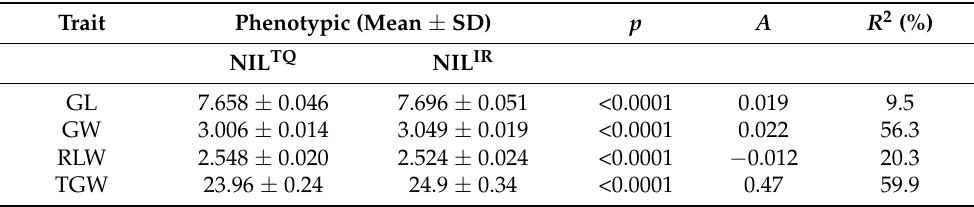
Table 5. The effect of qGS11 detected in an NIL